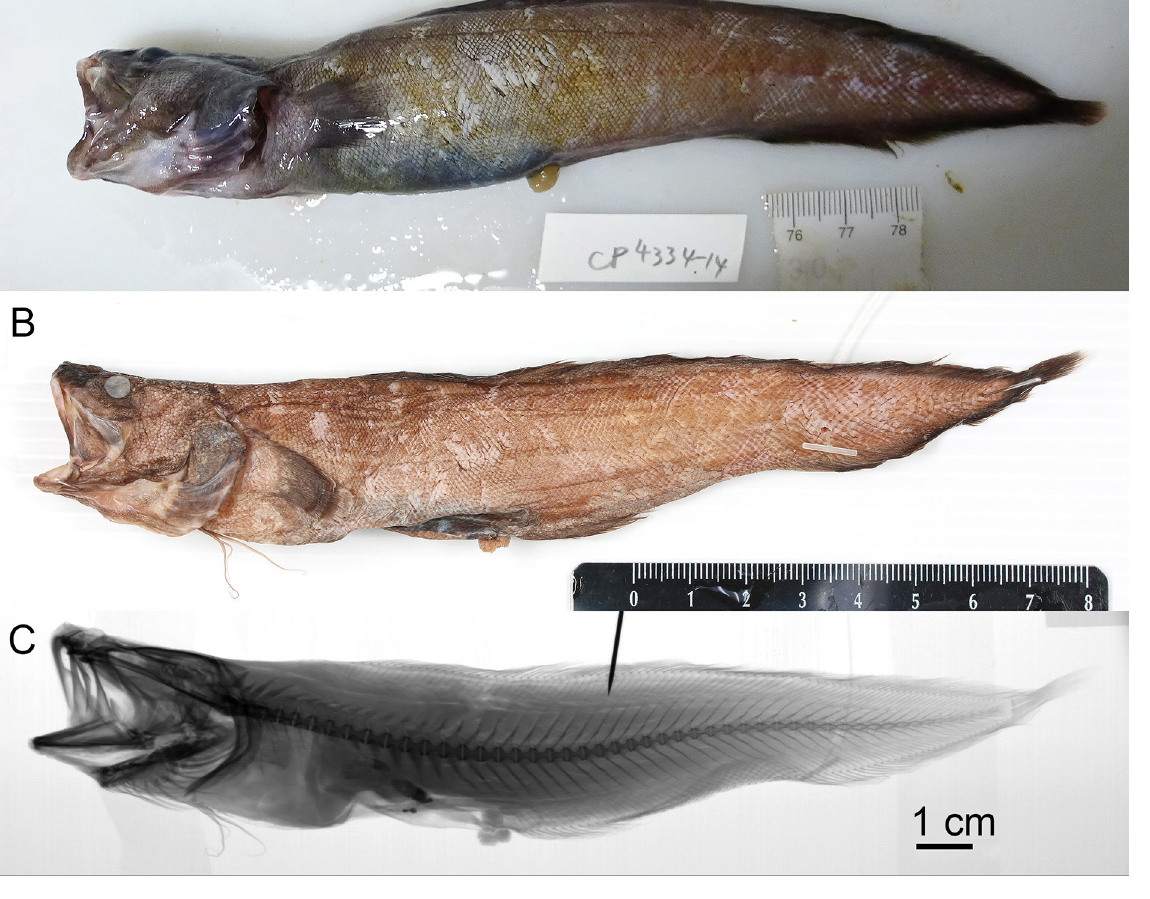
Fig. 3. Holotype of Luciobrotula polylepis sp. nov., 168.4 mm SL (NTUM 11915). A . Fresh specimen. B . Preserved specimen. C . Radiograph. Needle points to the lateral line